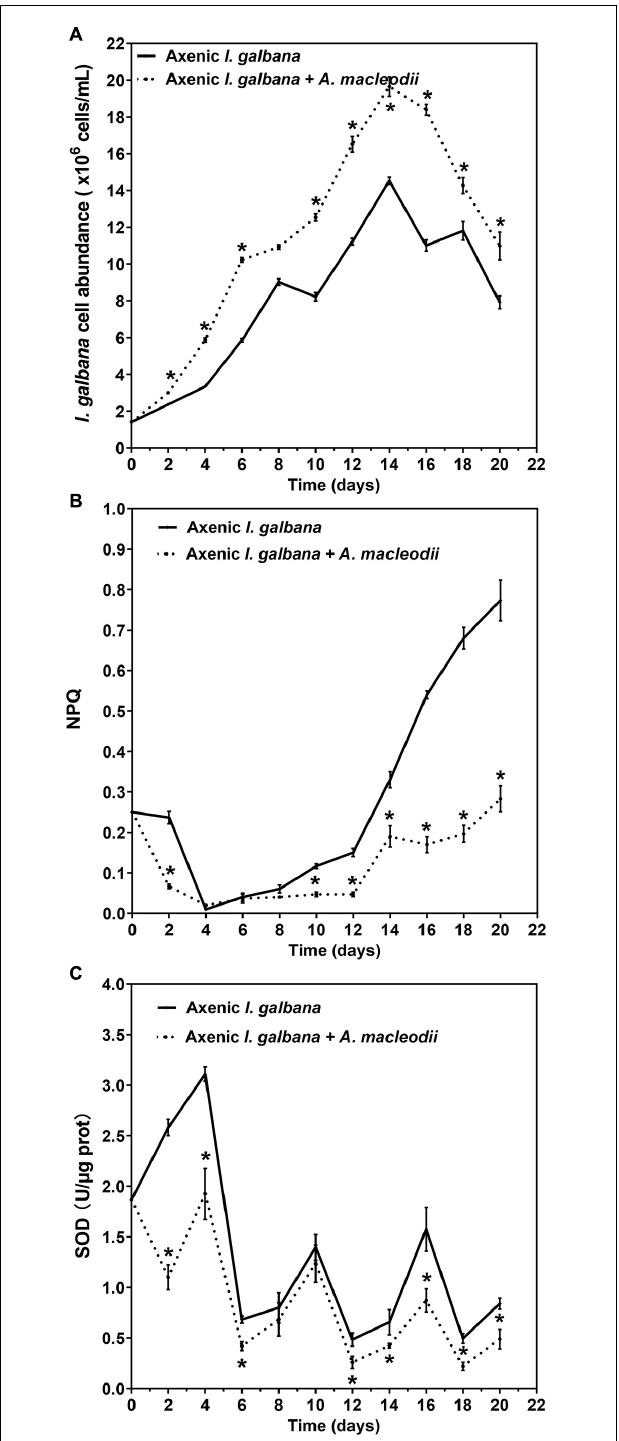
FIGURE 2 | Cell abundance (A) , non-photochemical quenching (NPQ) (B) and superoxide dismutase (SOD) activity (C) for I. galbana co-culture and mono-culture during 20 d exposure time. Significance of the differences between mean values was determined with Student’s t test. Error bars represent standard error (SE), while asterisks (*) indicate significant difference at p value <